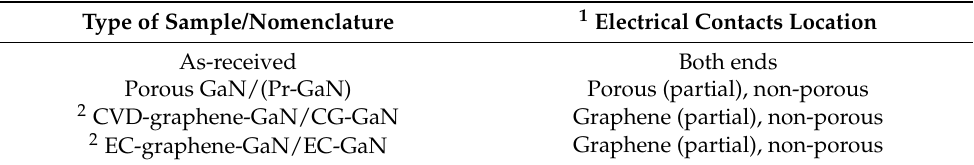
Figure 1. Schematic drawing (not to scale) of the UV photodetector. Table 1. List of UV photodetectors along with nomenclature in this work.